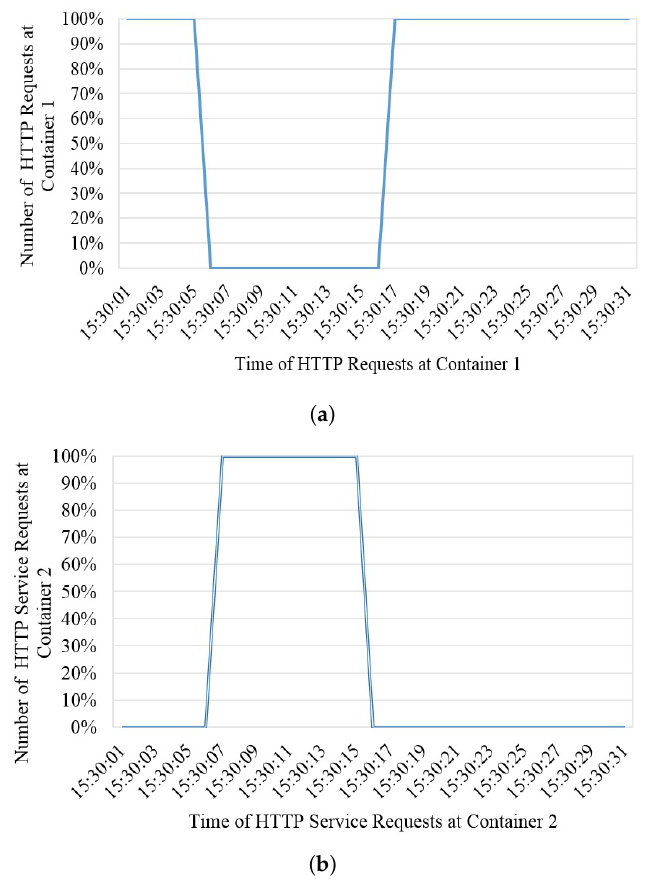
Figure 7. Antifragility and resiliency at the container level. ( a ) Container 1 HTTP requests, and ( b ) Container 2 HTTP